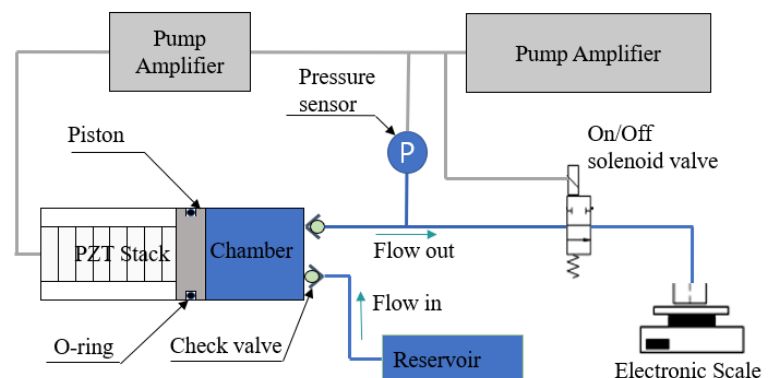
Figure 1. Schematic of the piezoelectric-hydraulic pump brake system.